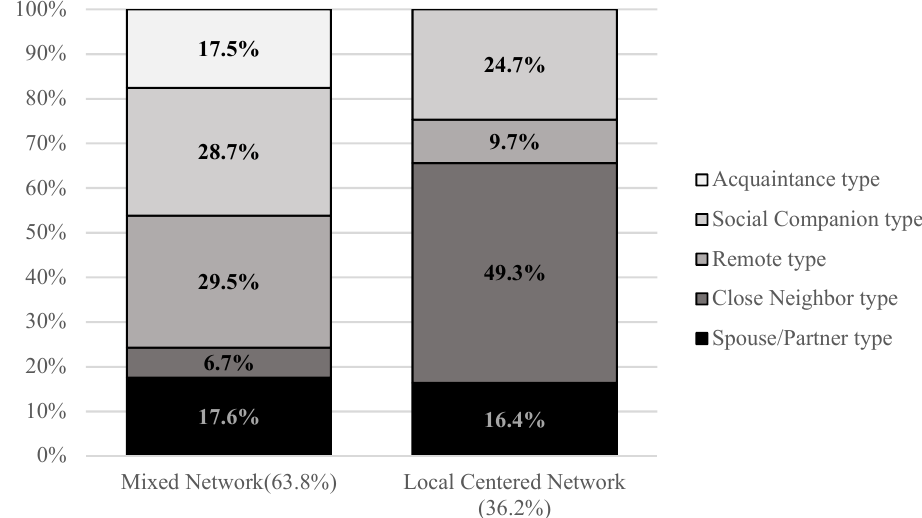
Figure 6. Two types of core discussion networks.